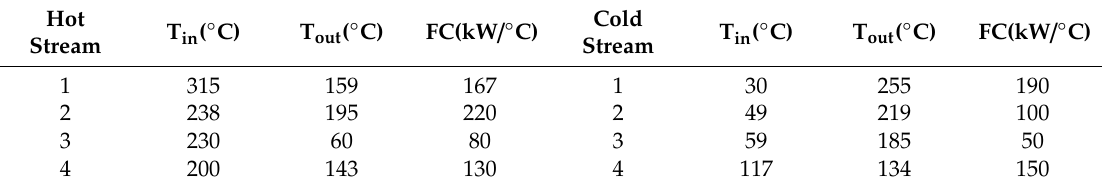
Table 1. Process data of the case